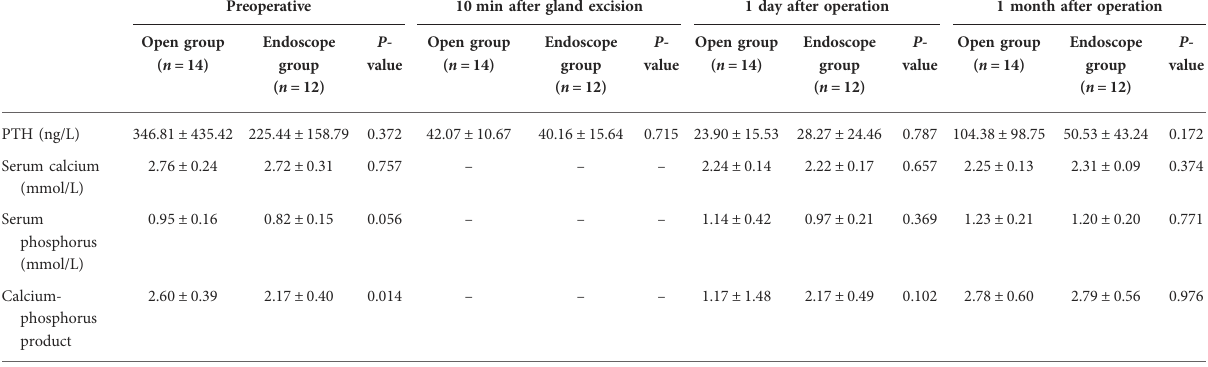
TABLE 3 Changes of PTH, serum calcium and serum phosphorus in all patients before and after